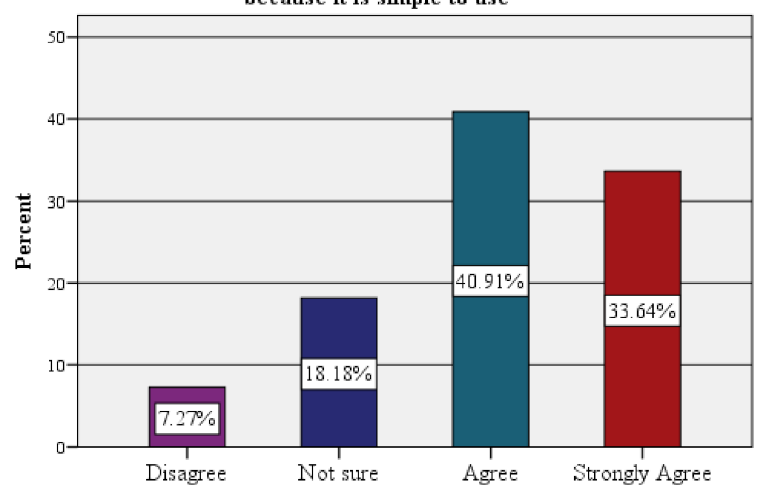
Figure 4. The simplicity of mobile apps for